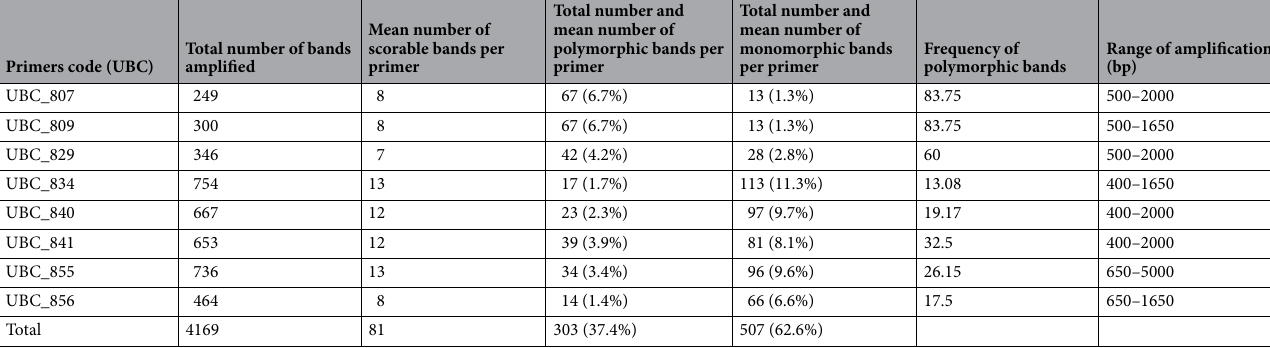
Table 3. Total, mean number and frequency of monomorphic and polymorphic bands for each ISSR primer from 10 randomly selected gamma-irradiated and non-irradiated plantlets.